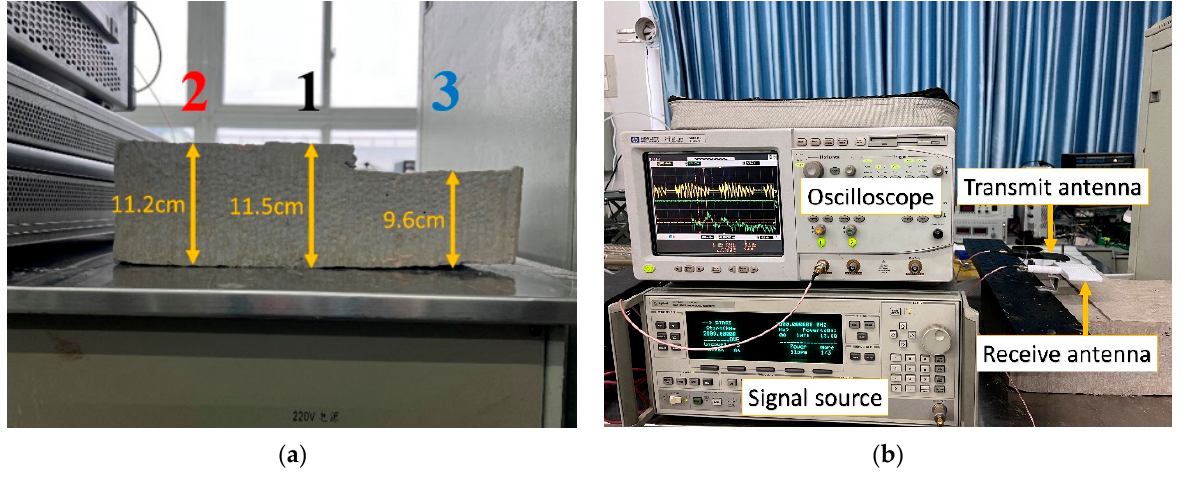
Figure 3. ( a ) Concrete model with three layers of thickness. ( b ) The proposed FMCW radar is used for model thickness measurement. for model thickness